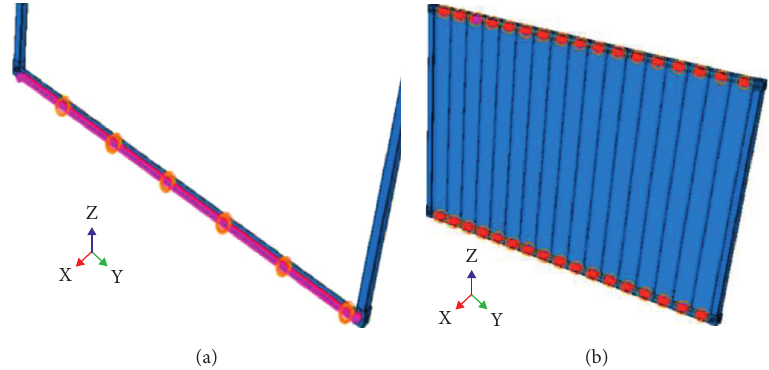
Figure 13: Binding forms of QY-2. (a) Surface binding of angle steel. (b) Point binding of bending plate.